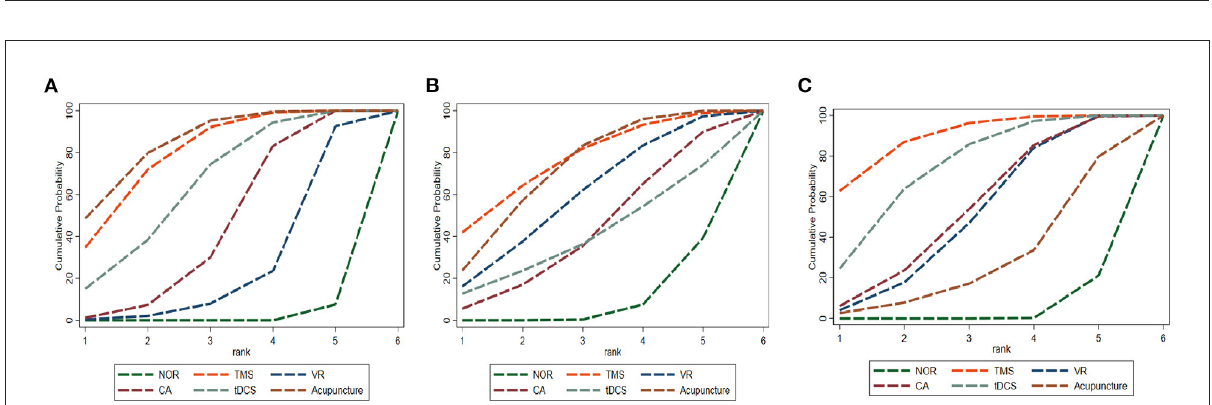
FIGURE5 Cumulative probability ranking curve of different interventions. (A) MOCA, (B) MMSE, (C) BI. The vertical axis represents cumulative probabilities, while the horizontal axis represents ranks. TMS, Transcranial Magnetic Stimulation; VR, Virtual Reality Exposure Therapy; CA, Computer-assisted cognitive rehabilitation; tDCS, Transcranial Direct Current Stimulation; Acu, Acupuncture; NOR, Normal treatment (including conventional rehabilitation and routine cognition training).